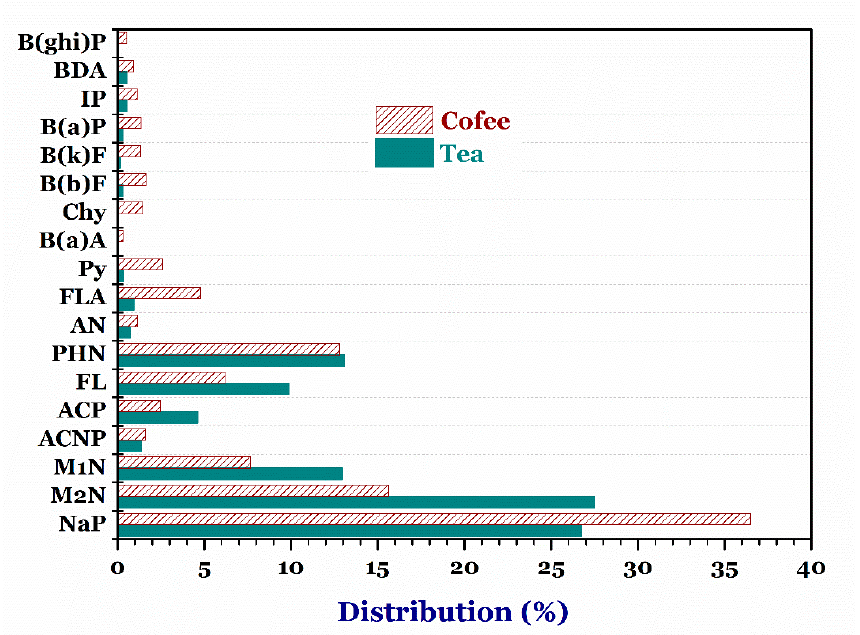
Figure 5. Distribution percentage of individual PAH in the tea and coffee samples. Note: Naphthalene, NaP; 2-methylnaphthalene, M2N; 1-methylnaphthalene, M1N; acenaphthylene, ACNP; acenaphthene, ACP; fluorene, FL; phenalthrene, PHN; anthracene, AN; floranthene, FLA; pyrene, Py; benzo(a)athracene, B(a)A; chrysene, Chy; benzo(b)fluoranthene, B(b)F, benzo(k)fluoranthene, B(k)F; benzo(a)pyrene, B(a)P; indeno(1,2,3-cd)pyrene, IP; dibenz(a,h)anthracene, BDA; and benzo(g,h,i)perylence, B(ghi)P.